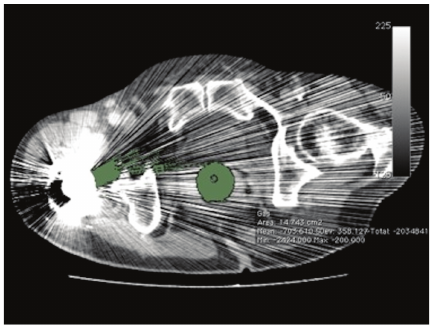
Figure 2: Axial CTC image through the lower rectum demonstrat- ing aliasing artifact from a right hip arthroplasty which spuriously creates pixels with Hounsfield unit values of less than − 350 in the soft tissues. This resulted in inaccurate segmentation along the gas column (green ROI). All patients with hip arthroplasty devices were therefore excluded from this study.